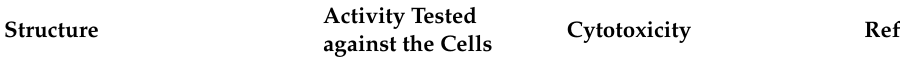
Compound no. Structure